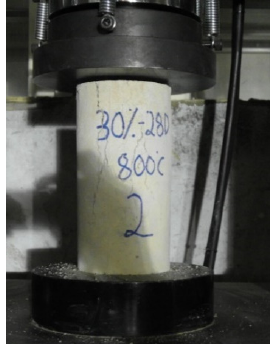
Figure 2. Compression test.